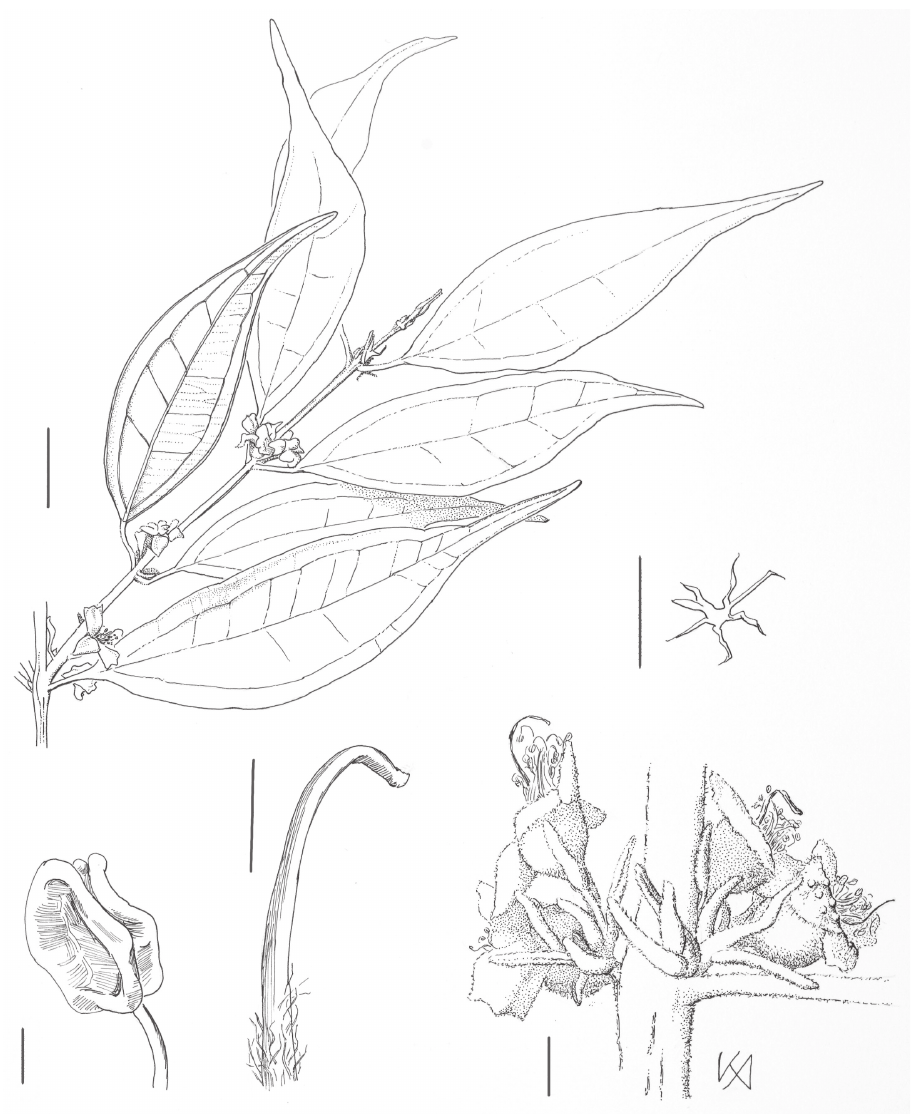
Figure 4. Rhodamnia makumak N. Snow. Drawing of isotype at A ( R. Pullen 8433 ). Clockwise from top: branchlet (bar = 1 cm); stellate trichome (bar = 0.1 mm); inflorescences (bar = 1 mm); style (bar = 1 mm); dehisced anther (bar = 0.3